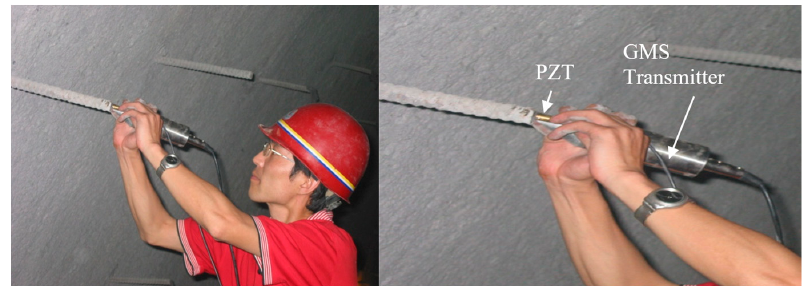
8 of 13 Figure 8. The denoised waveform by wavelet denoising algorithm ( top ) and the periodic pattern of the instant phase ( bottom ). 4. Field Tests 4.1. Site 1 On 26 April 2016, a series of field tests were performed in a highway tunnel. The highway tunnel was located in Wuqi County, Yanan City, Shaanxi Province, China. The giant magnetostrictive (GMS) actuator has the best energy conversion rate at frequency around 10 kHz. This property is dependent on the sizes of the components of the GMS actuator. In practice, properly lowering the excitation frequency can reduce the attenuation of the stress wave. The selected excitation frequency should ensure the excited stress wave has multiple reflections. Therefore, the excitation signal was a unipolar pulse which has a dominant frequency at 7.8 kHz. The sampling frequency was 1 MHz. During the field tests, 50 rock bolts were randomly chosen. Measurement for each rock bolt was repeated 10 times. In addition, in situ pullout tests were performed for five of the chosen rock bolts to verify the measurement accuracy of the proposed rock bolt length measuring method . Table 1 lists the results of the five rock bolts, which shows that the proposed method is highly accurate in determining the length of installed rock bolts. Measurements from one of the rock bolts were shown. This rock bolt had a length of 2 m according to the pullout test. Figures 9–12 show the steps and data analysis results. Table 1. The results for five of the chosen rock bolts in a highway tunnel in Wuqi County. Rock Bolt Number